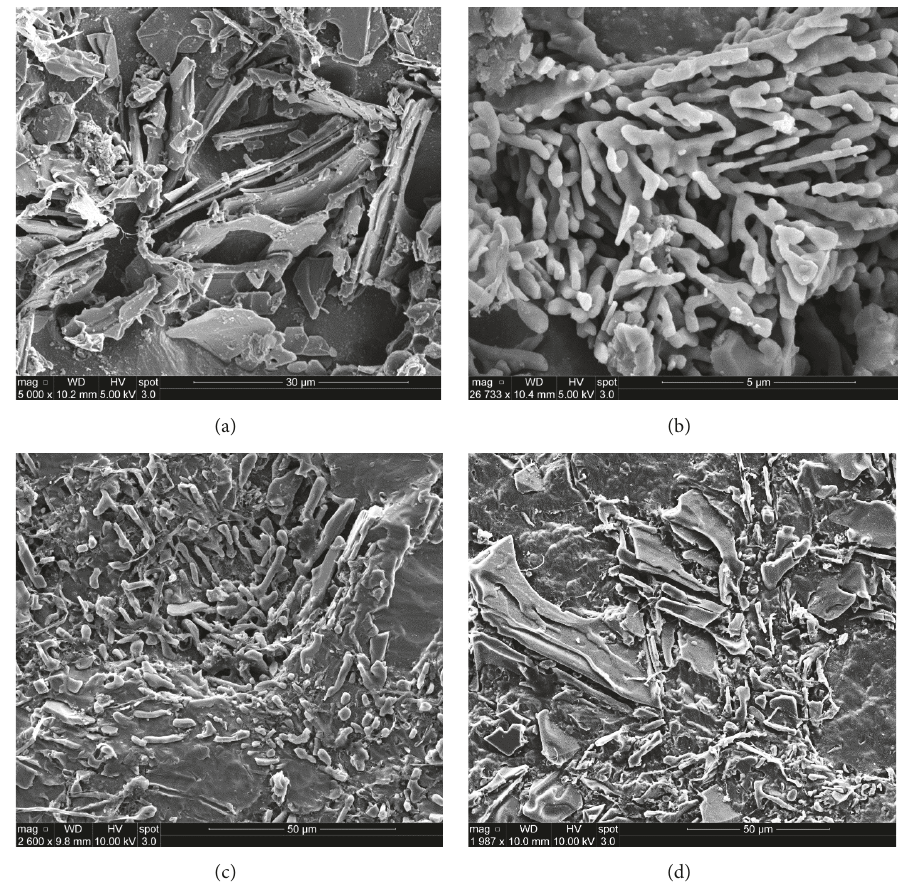
Figure 13: Secondary electron images of deeply etched (a) TE alloy, (b) TES alloy, (c) TE3S alloy, and (d) TE9S